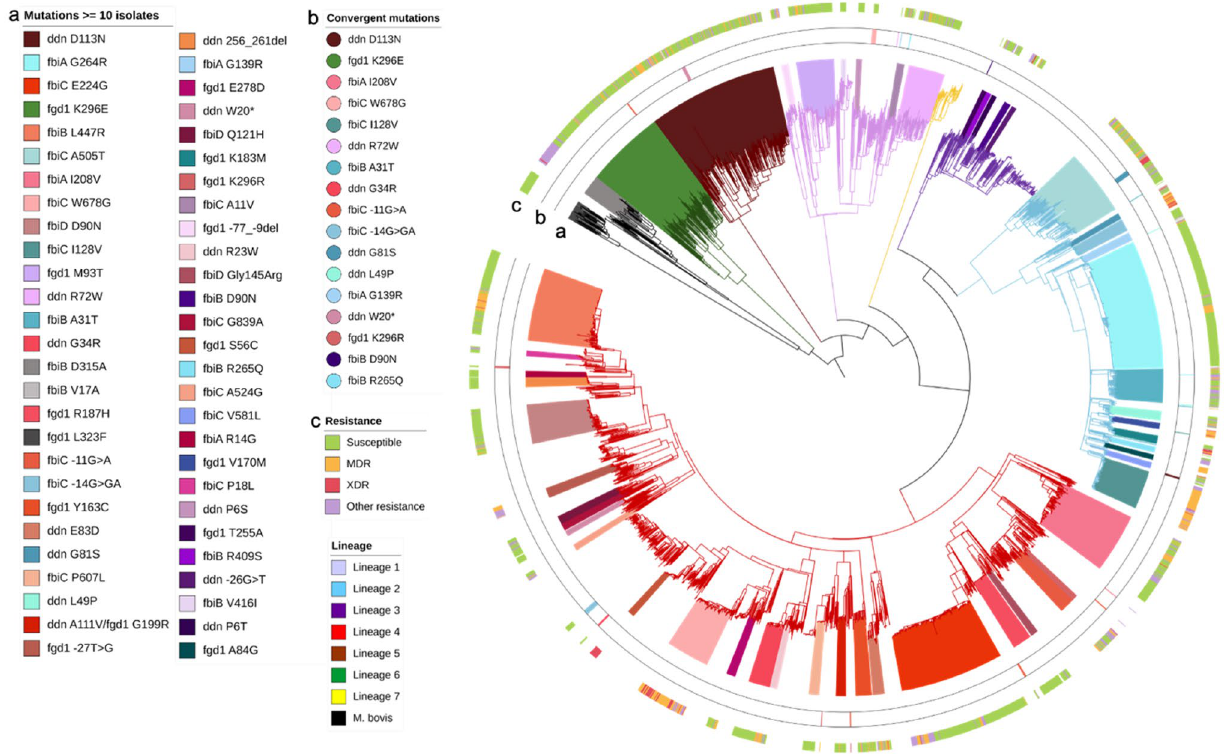
Figure 3. Phylogenetic tree of high frequency mutations (≥ 10 isolates) in delamanid and pretomanid candidate genes ( fgd1 K270M and R64S, fbiC −32A > G and T273A, fbiA T302M and fbiB K448R found in > 290 isolates not represented). Clades formed by isolates harbouring the same mutations are differentiated by colour. The outer ( c ) track shows the resistance phenotype; the second track ( b ) shows the convergent mutations that have arisen in more than one clade; the third track ( a ) shows the clades formed by isolates harbouring the same phylogenetic-related mutations. Branches are coloured by lineage as per